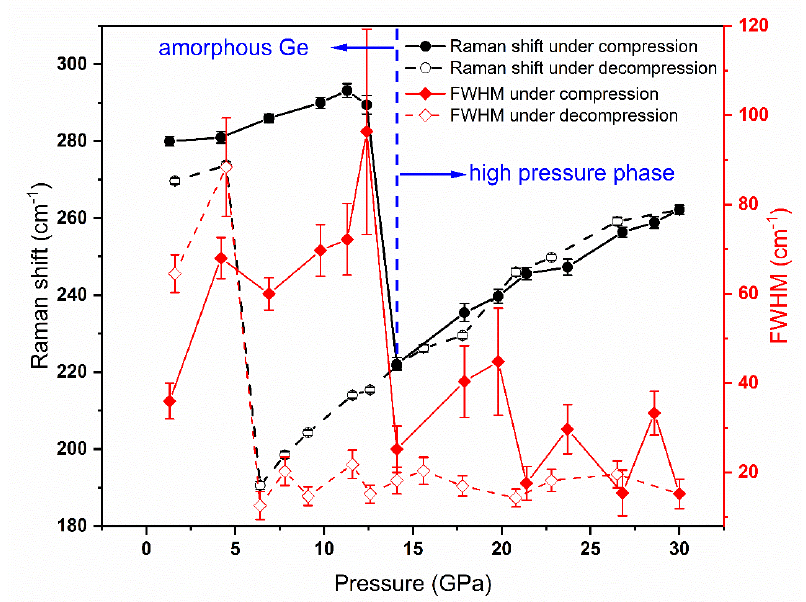
Figure 7. The pressure-dependent Raman shift (black curve) and FWHM (red curve). Solid symbols mean compression, while open symbols represent decompression. Vertical lines are error bars.